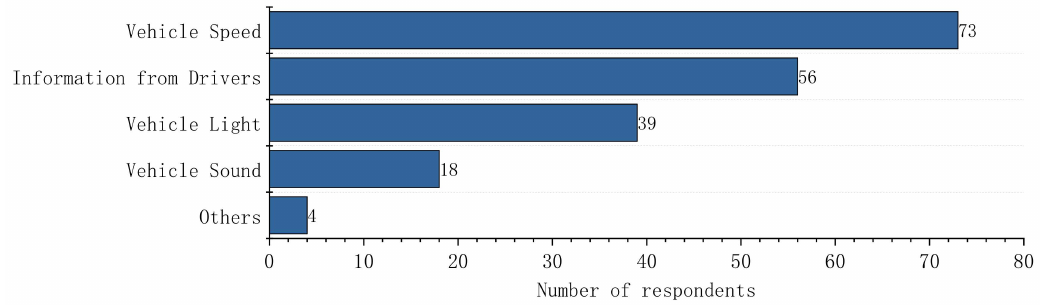
Figure 6. The considerations of pedestrians when making crossing